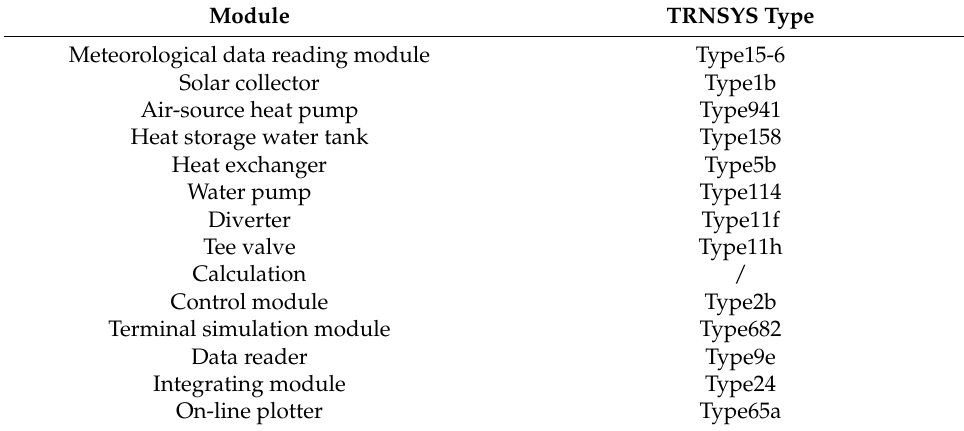
Table 2. Main simulation modules of the